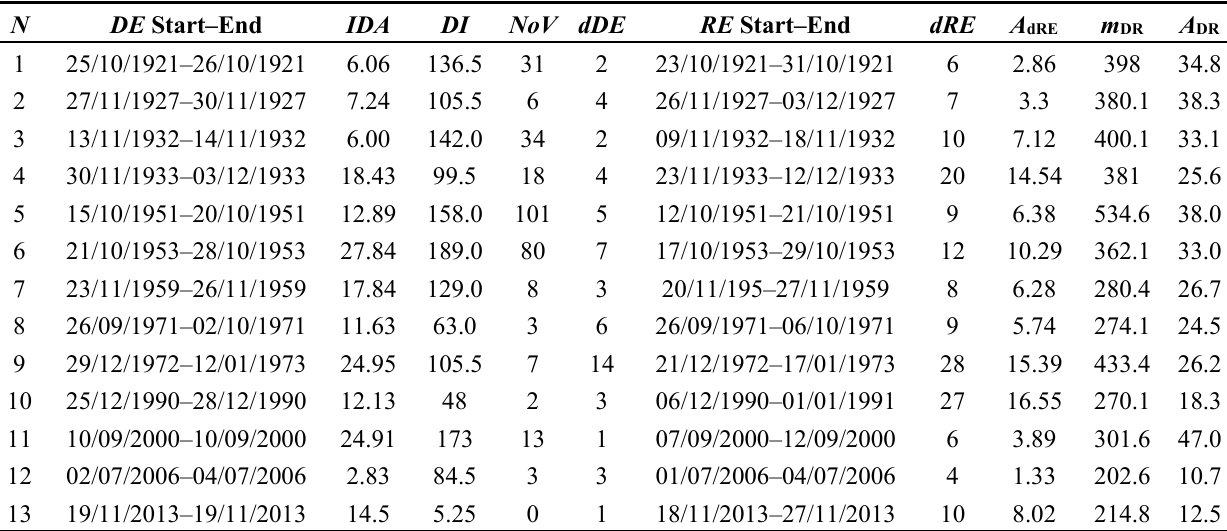
Table 1. Severe DHEs that have occurred in Calabria since the 1920s, chronologically